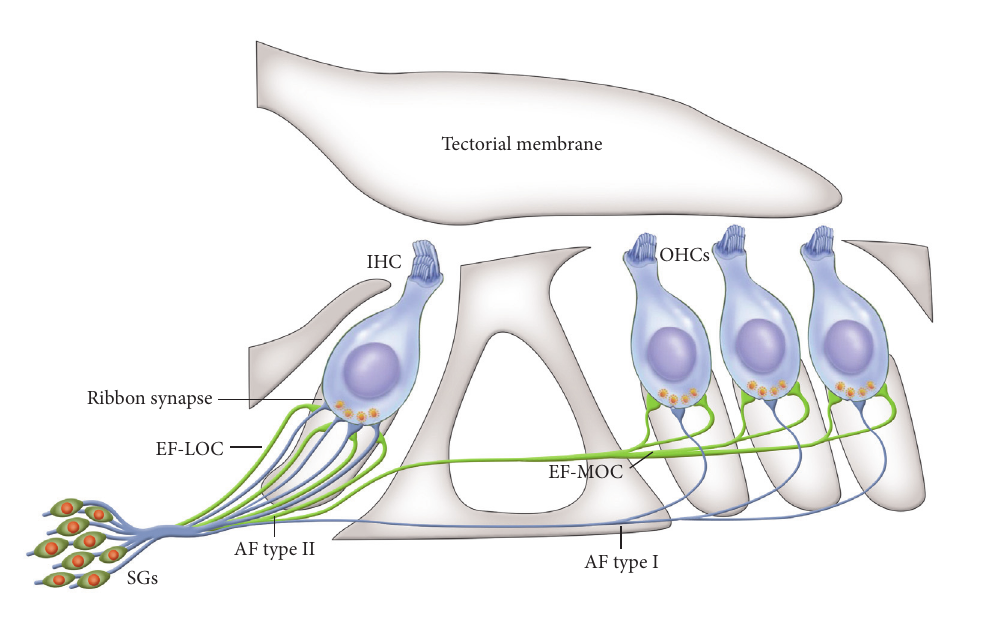
Figure 3: Schematic drawing of the innervation of hair cells. IHC: inner hair cell; OHCs: outer hair cells; AF: afferent fiber; EF: efferent fiber; LOC: lateral olivary complex; MOC: medial olivary complex.